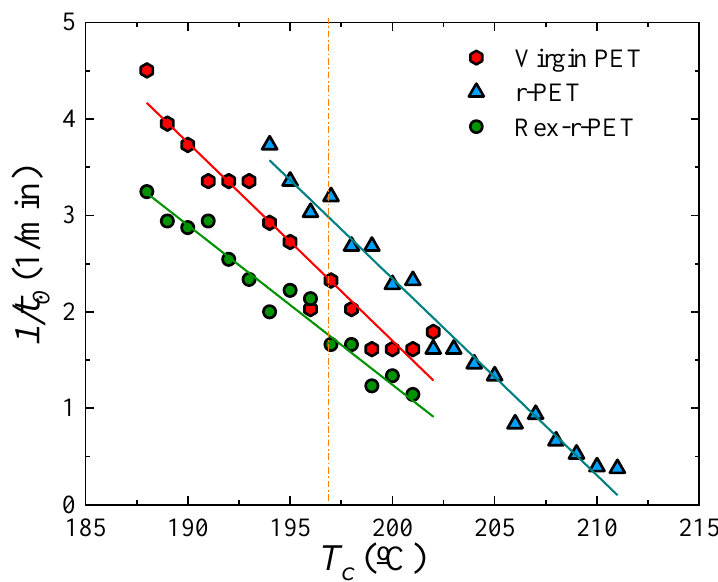
Figure 6. Primary nucleation rate obtained by DSC for the samples isothermally crystallized from the melt as a function of T c .